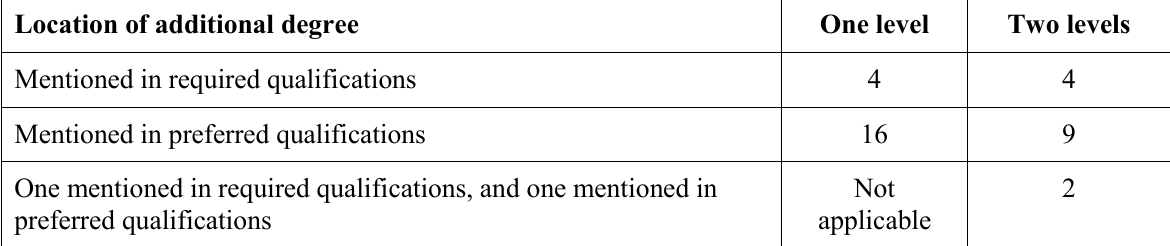
Table 4 : Locations of additional degrees (one degree level or two degree levels).